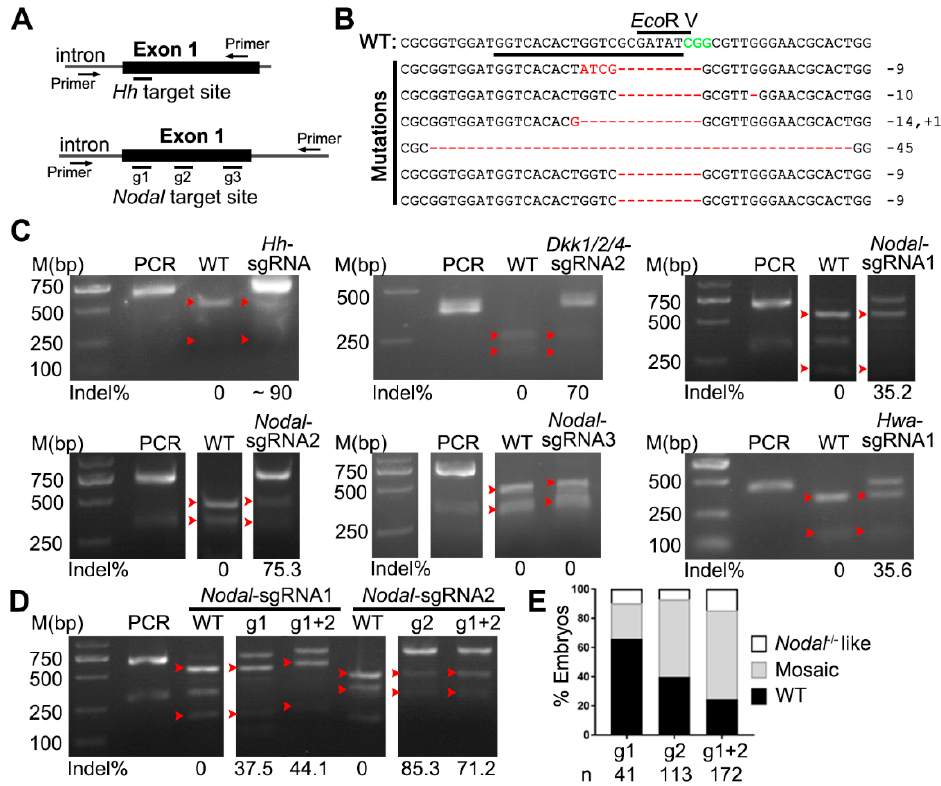
Figure 2. The broad feasibility of the CRISPR / Cas9 system in genome editing of amphioxus. ( A ) Schematic showing the position of the target site and the primers used for PCR amplicons in the Hh and Nodal loci in amphioxus. ( B ) Sanger sequencing results showing mutations (red) mediated by Cas9 / sgRNA in an Hh allele. The wild-type (WT) reference sequence is shown at the top. The underlined sequence is the target site and CGG (green) is the PAM sequence. ( C ) Mutations were detected using a restriction enzyme digestion assay in the Hh , Dkk1 / 2 / 4 , Nodal and Hwa loci. ( D ) Comparison of mutation e ffi cacies between single-sgRNA and dual-sgRNAs injections in the Nodal locus. ( E ) Phenotypic evaluation of embryos injected with single-sgRNA or dual-sgRNAs targeting the Nodal gene. Two kinds of phenotypes were counted: embryos of the ‘ Nodal − / − -like’ phenotype exhibited left isomerism morphology resembling embryos lacking Nodal signaling, and embryos of the ‘mosaic’ phenotype showed left-right defects in positioning of some organs. The number (n) of embryos evaluated is shown for each condition. In panels C and D, PCR denotes the PCR products not treated with the restriction enzyme, WT denotes digestion of PCR products from control (uninjected) embryos with the restriction enzyme, red arrowheads indicate bands released by restriction enzyme digestion and the induced mutation ratios (estimated as percentages of uncut PCR products) are labeled under each gel image.